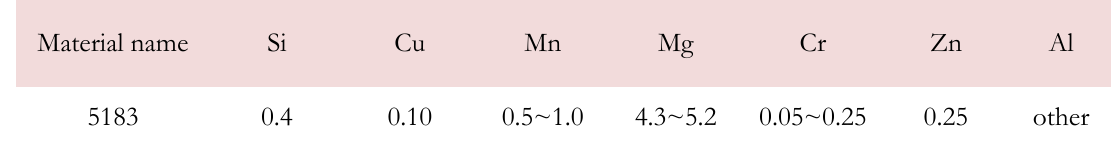
Table 4: Chemical composition of 5183 aluminum alloy welding